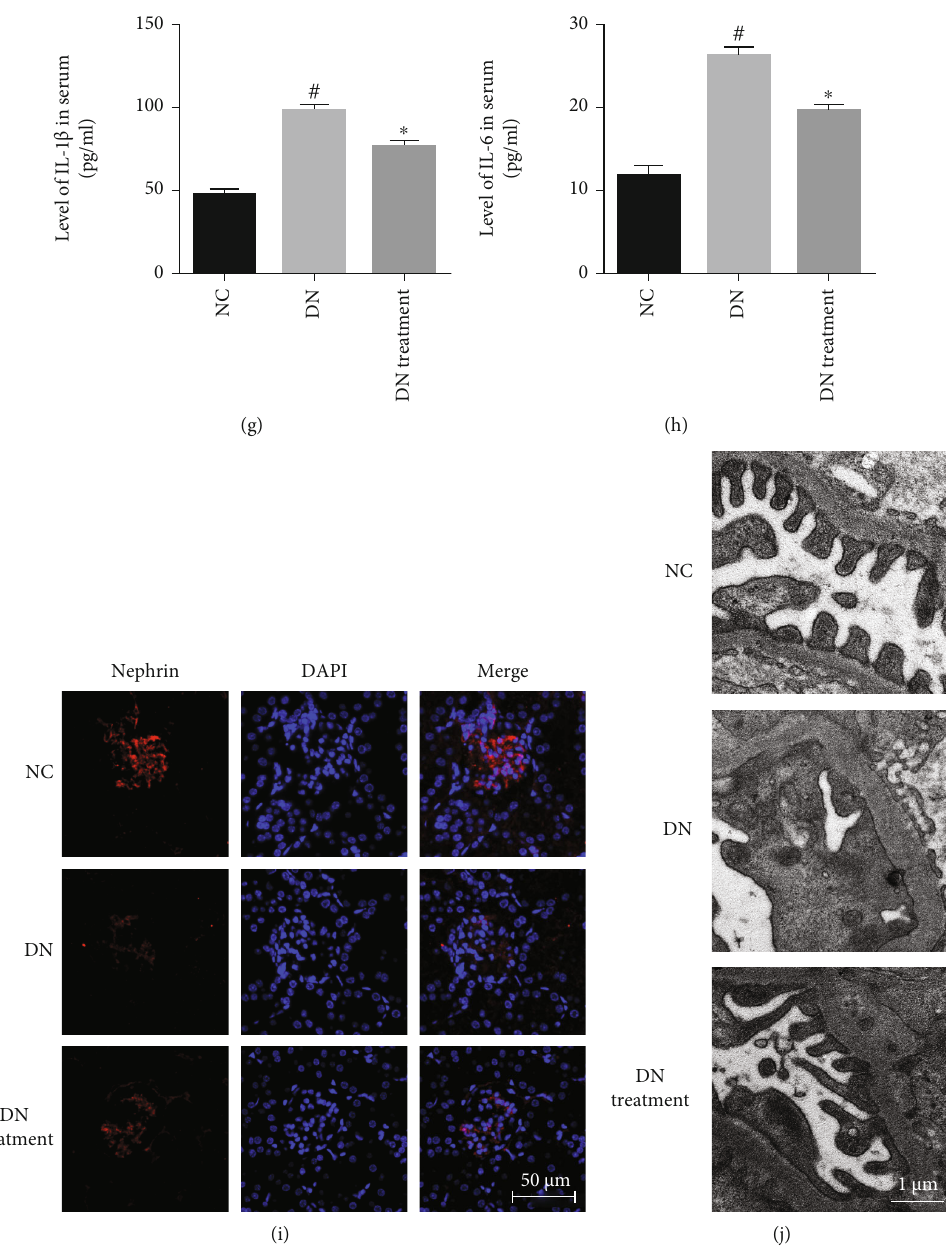
Figure 1: The impact of miR-155 on in fl ammation, renal morphology, and function in diabetic KK-Ay mice. (a, b) miR-155 expressions serum and kidney tissue as determined using real-time PCR. (c, d) ACR and mAlb levels were used to assess degree of renal function. (e – h) In fl ammatory cytokine expressions (MCP-1, TNF- α , IL-1 β , and IL-6) in serum was measured using ELISA. (i) The expression levels of nephrin were determined using immuno fl uorescence. (j) The morphology of the kidney was observed under TEM. # Compared with NC group, P < 0 : 05 ; ∗ Compared with DN control group, P < 0 : 05